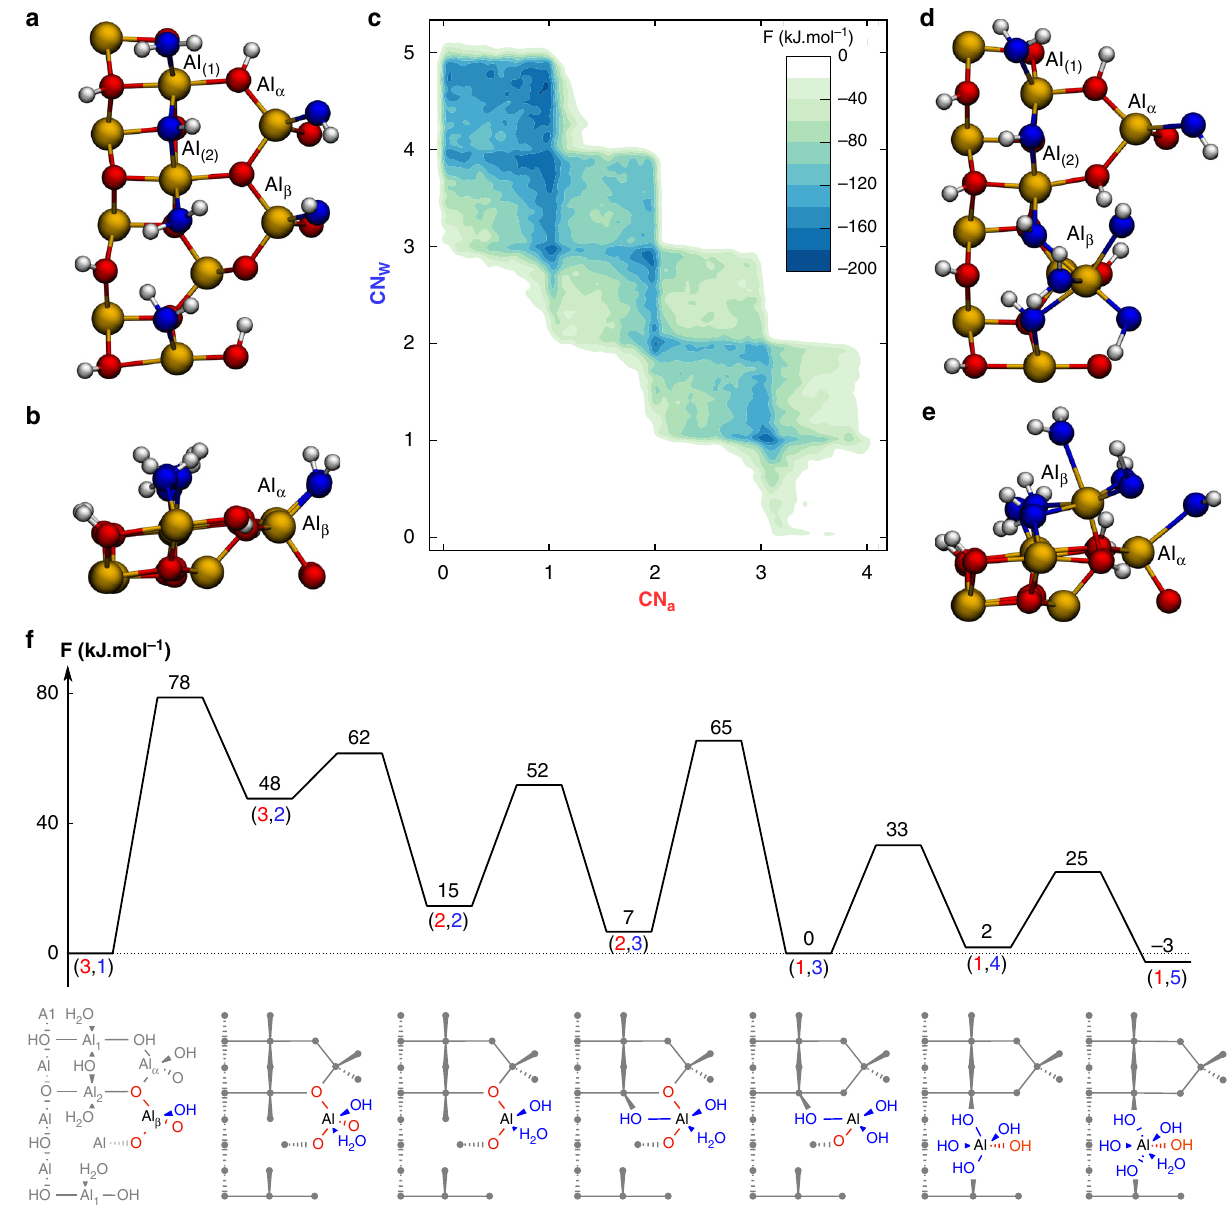
Fig. 2 Exploration of the reactivity of tetrahedral Al β on γ -Al 2 O 3 (110) from ab initio metadynamics. a , b Structure of the initial surface with chemisorbed water molecules or fragments (the oxygen atoms of which are shown in blue) adsorbed on tetrahedral Al α and Al β and octahedral Al (1) and Al (2) . c Free energy surface obtained from the metadynamics simulation on Al β using the coordination numbers to alumina oxygen atoms (CN a ) and to water molecules and fragments (CN w ) as variables. The simulation starts from the point of coordinates (CN a ,CN w ) = (3,1). d , e Structure of the last intermediate obtained from the hydration of tetrahedral Al β with (CN a , CN w ) = (1,5). f Projected free energy pro fi le with the structure of each intermediate and the corresponding (CN a ,CN w ). Yellow and white balls represent aluminum and hydrogen atoms, respectively. The color red is used for alumina oxygen atoms and the associated CN a . The color blue is used for water oxygen atoms and the associated CN